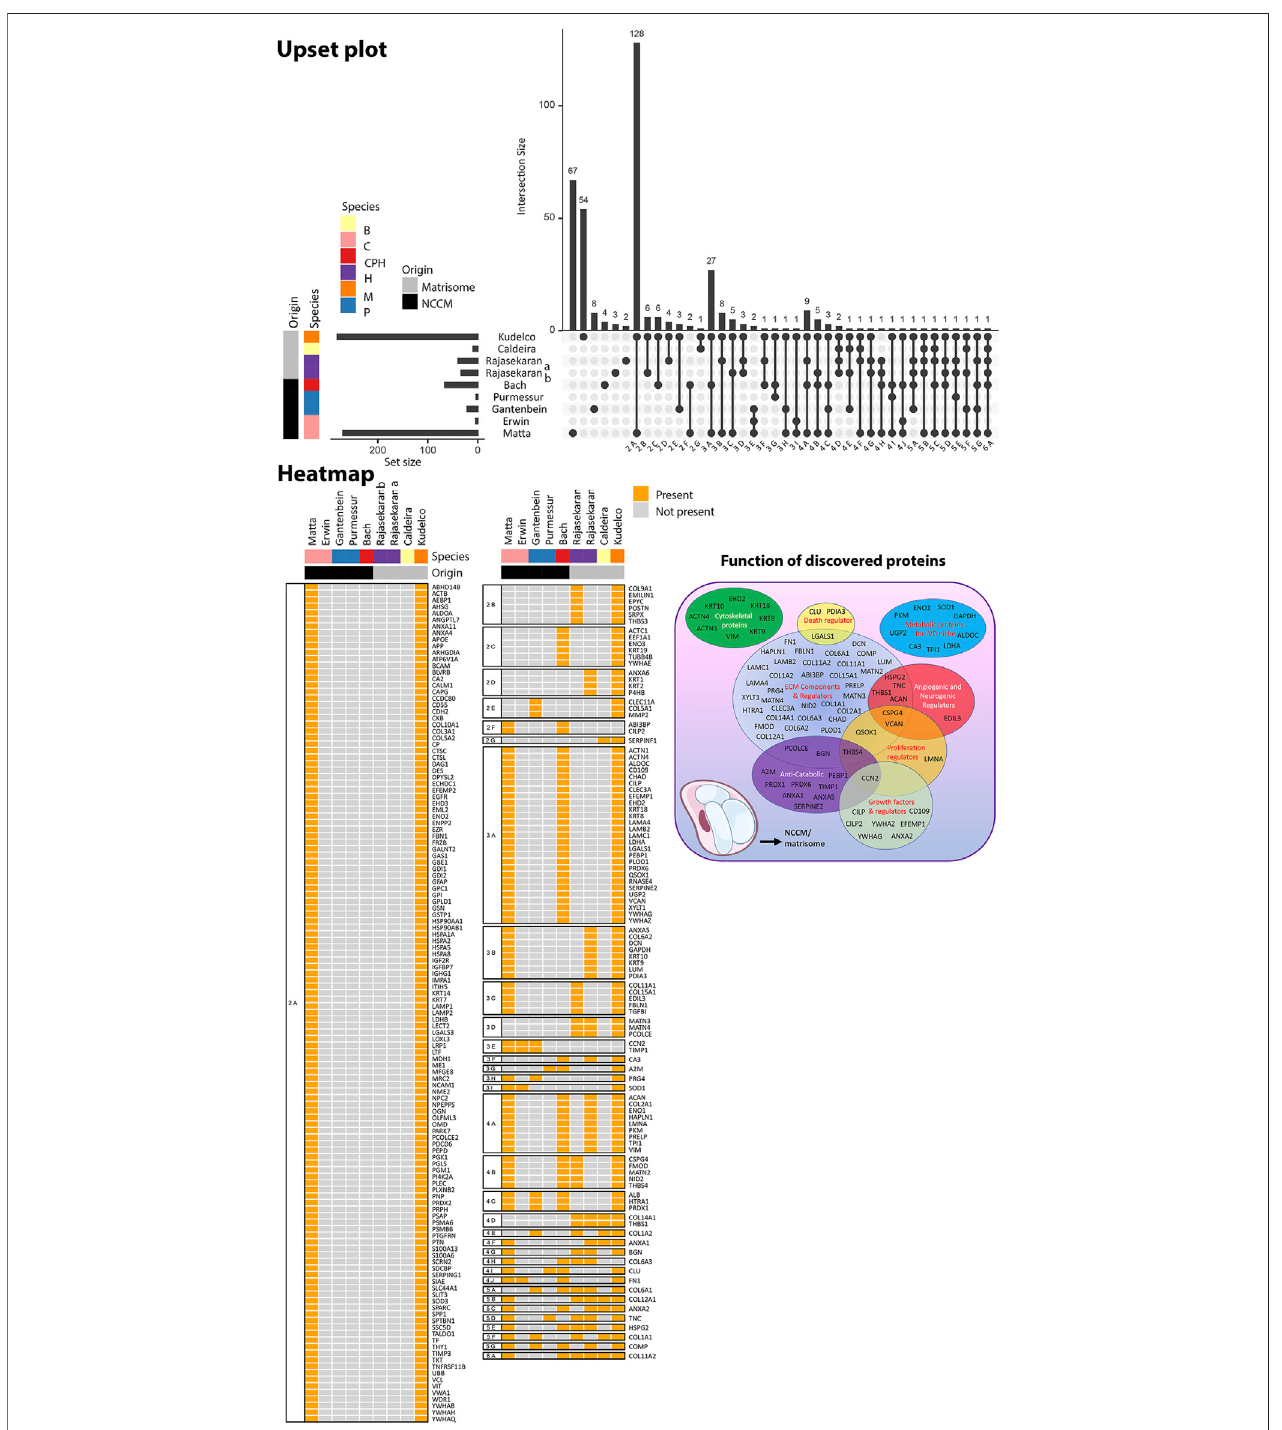
FIGURE 7 | Overview of the proteins that were identi fi ed in human, canine, and/or porcine NCCM and murine, human and bovine fetal NC-rich matrisome. The Upset plot depicts the number of proteins identi fi ed in the speci fi c study and relates to the number of proteins that overlap with other studies. Intersection size indicates the number of proteins identi fi ed in each speci fi c comparison. The set size indicates the number of proteins identi fi ed in the speci fi c study. The heatmap depicts the overlap of proteins between the different studies. The main functions of the discovered proteins are provided in a Venn diagram. Purmessur et al. (2011) and Gantenbein et al. (2014) identi fi edproteins inporcineNCCM, whileErwinet al. (2006) and Matta et al.(2017) used canine NCCM. Inthe study ofBach and de Vries et al. (2016), only proteins that were identi fi ed in both human, canine, and porcine NCCM were included in this analysis. Rajasekaran et al. (2020), Rajasekaran et al. (2020b) identi fi edproteins inhumanfetalmatrisome,Caldeiraet al.(2017) inbovine fetalmatrisome,andKudelkoetal.(2021) inmurinematrisome.Thestudy byTamet al. (2020) was not included in this comparative proteomic overview focusing on NC-rich tissues, since it used NPC-containing adolescent human NP tissue.